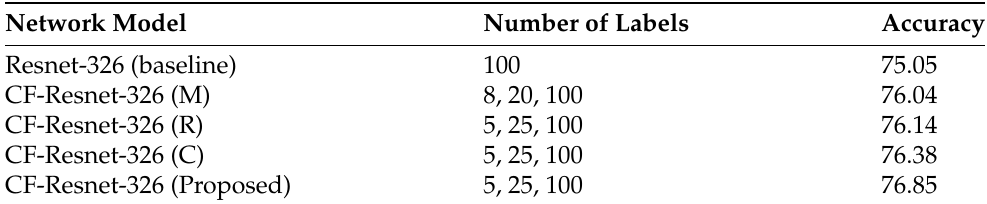
Table 8. Best classification accuracy according to the grouping method on CIFAR-100. (M), (R), and (C) denote manual, random, clustering ,